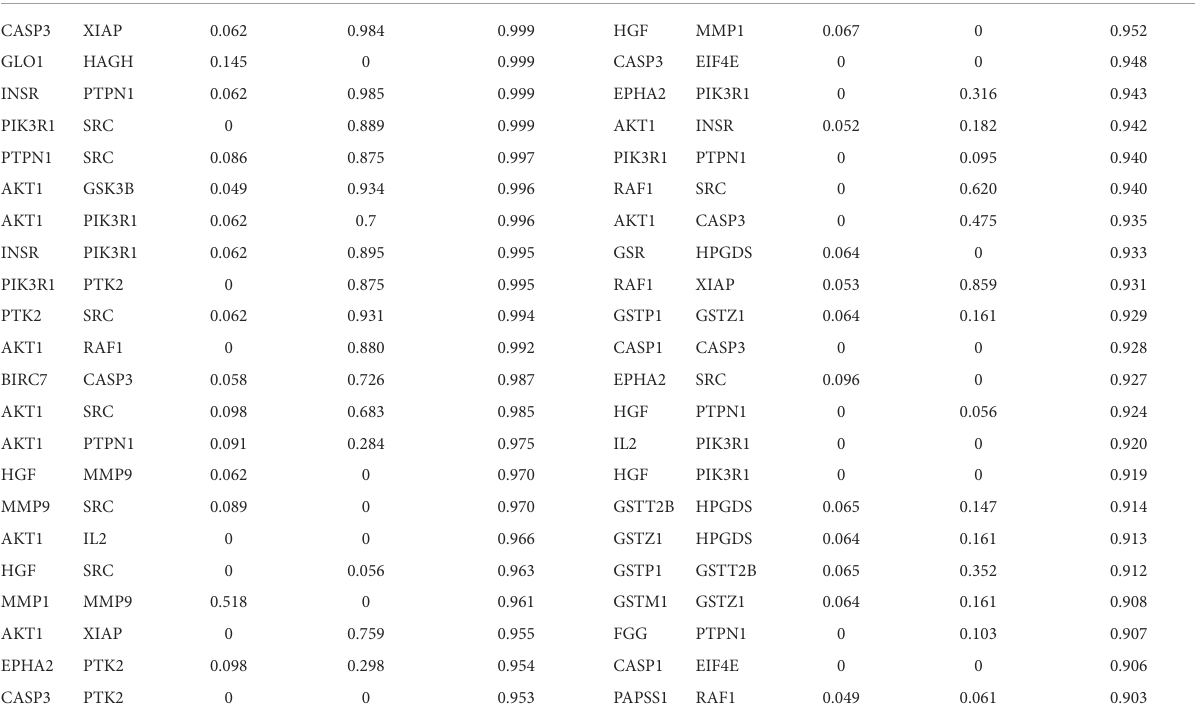
TABLE 1 The line information in protein-protein interaction network (PPI). Node1 Node2 Coexpression Interaction Combined score Node1 Node2 Coexpression Interaction Combined